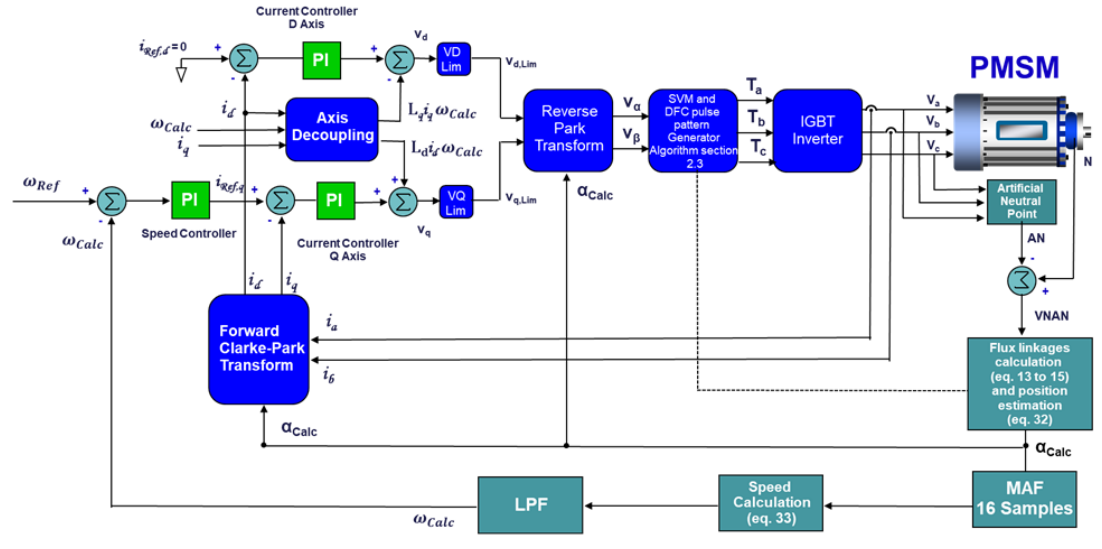
Figure 6. Sensorless speed control with SVM-based DFC measurement sequence.